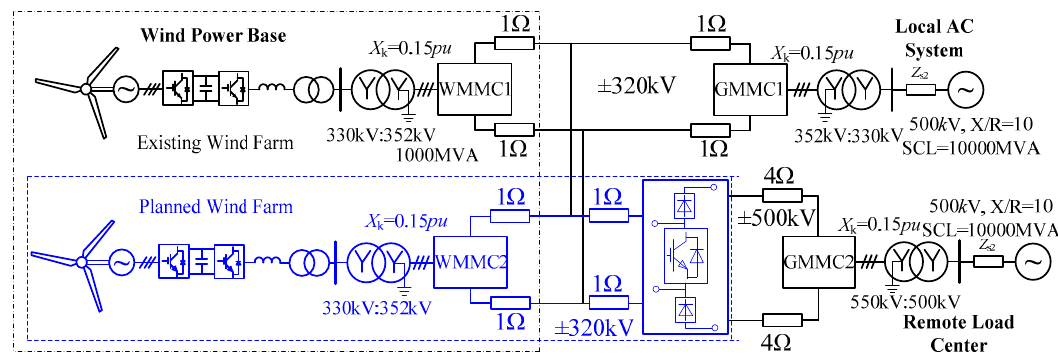
Figure 3. Schematic of a system for integrating wind power through UUDAT.